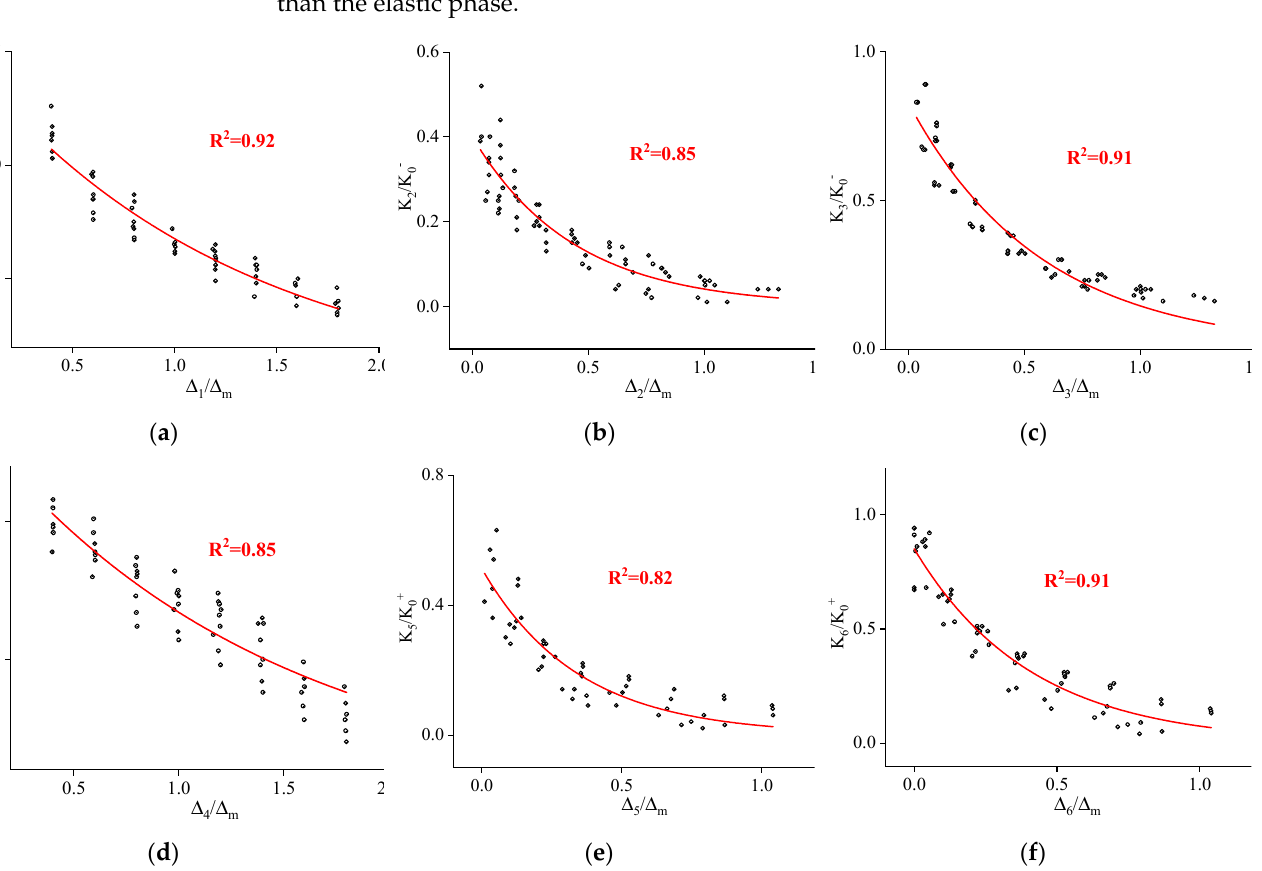
Figure 14. Hysteresis Rules.